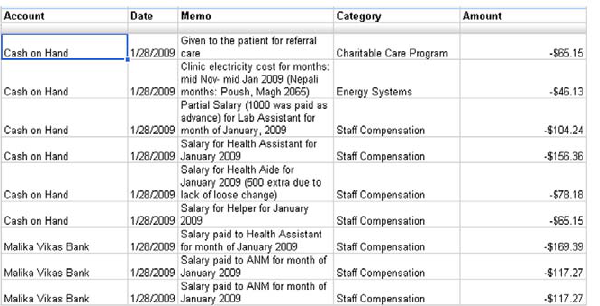
Figure 3. Screenshot of the Nyaya Health budget. The line-by-line budget, updated monthly, is posted online. The dollar amounts shown are converted from Nepali Rupees using daily closing exchange rates.